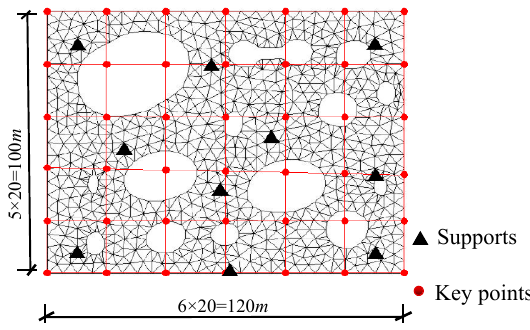
Figure 11. The size of the initial structure and constraints.